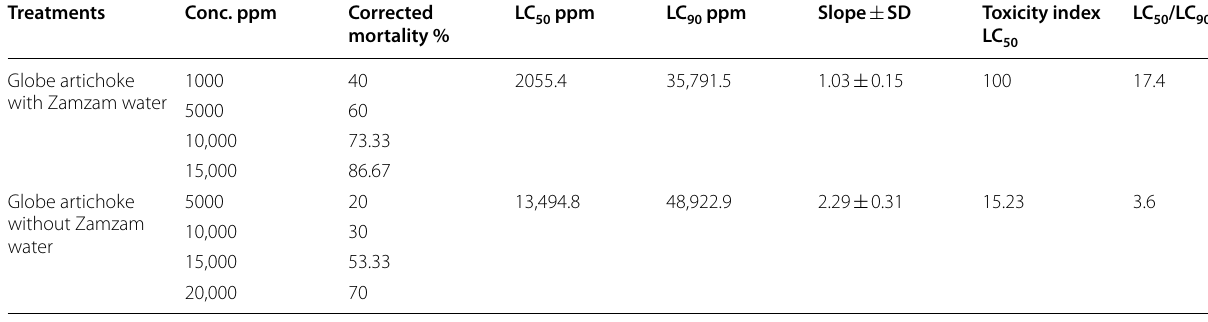
Table 2 Efficiency of globe artichoke extract with and without Zamzam water against P. solenopsis Treatments Conc. ppm